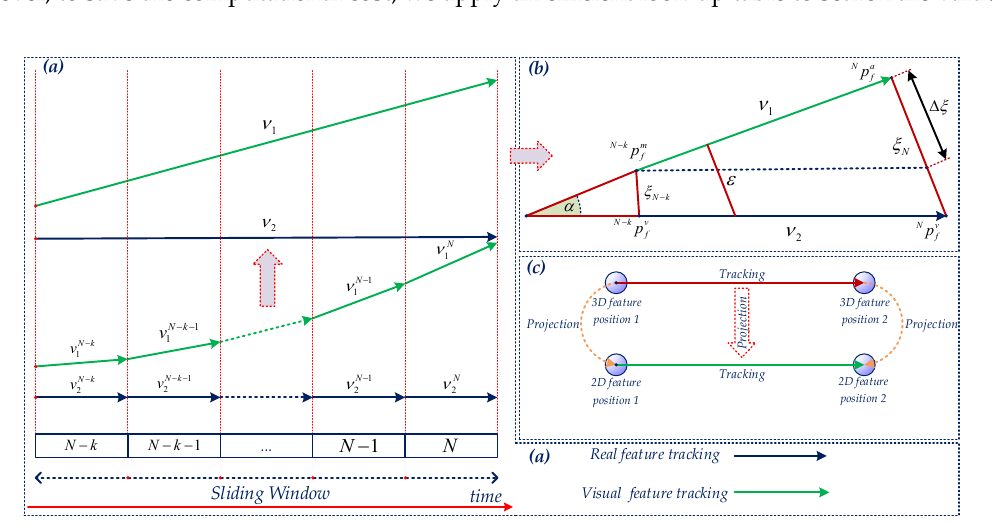
Figure 7. The illustration of the outlier removal strategy of a dynamic visual feature. ( a ) 2D feature tracking of the feature within a sliding window from time steps N − k to N , where each green arrow indicates the optical flow of the feature observed in the image plane and dark green arrow represents the estimation movement of the feature in each period. ( b ) The geometrical method based-outlier removal from start to end time step of the sliding window, the results are inferred from ( a ). ( c ) The half above represents the tracking in the 3D environment, and the half bellow demonstrates the projection of the feature on the image